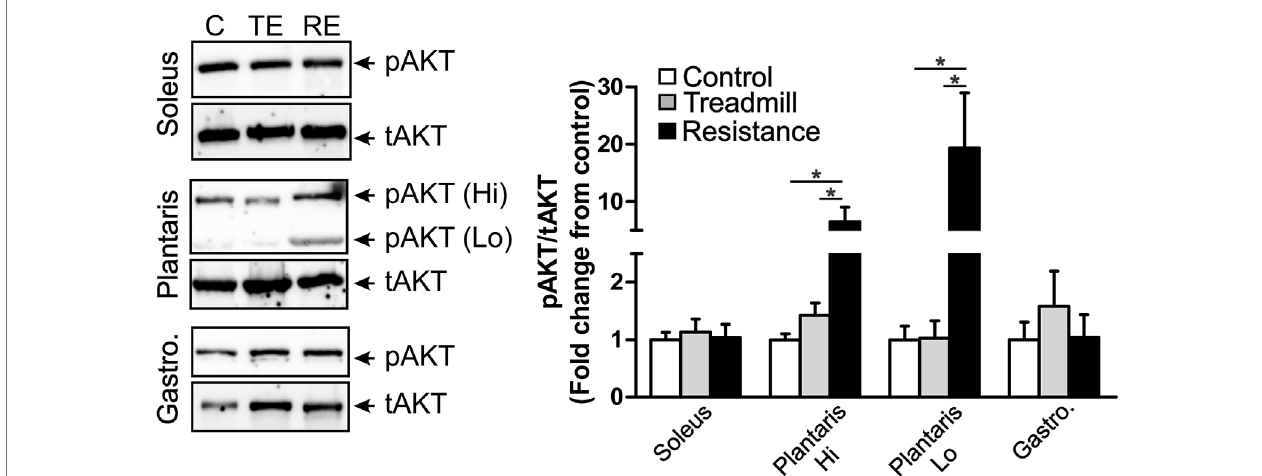
FIGURE 6 | Resistance exercise enhances the expression levels of the phosphorylated fraction of AKT in the plantaris muscle. Left panel shows immunoblots of phosphorylatedAKT(pAKT)andtotalAKT(tAKT)detectedinthesoleus(topmicrograph),theplantaris(middlemicrograph)andthegastrocnemius(bottommicrograph). ThereweretwoIRbandswithahigh(90KD)andlow(64KD)apparentmolecularweightsintheplantarismuscle.OnepAKT-IRbandwasseeninthesoleusmuscleatthe apparent molecular weight of 64 KD and one pAKT-IR band was seen in the gastrocnemius at the apparent molecular weight of 66 KD. One major tAKT IR band was detected in all three muscles. The right panel shows bar graph illustrating semi-quantitative analysis of the expression of the phosphorylated fraction of AKT relative to the total AKT (pAKT/tAKT) in the soleus, plantaris (high MW: Hi and low MW: Lo) and gastrocnemius muscles of rats under control condition (C; n = 5) or subjected to eithertreadmill(TE; n =5)orresistanceexercises(RE; n =5).Resistanceexerciseledtoasigni fi cantincreaseintheexpressionofthefractionofpAKTintheplantaris,but not in the gastrocnemius or the soleus muscles. Data are presented as mean ± SEM. * p < 0.05.